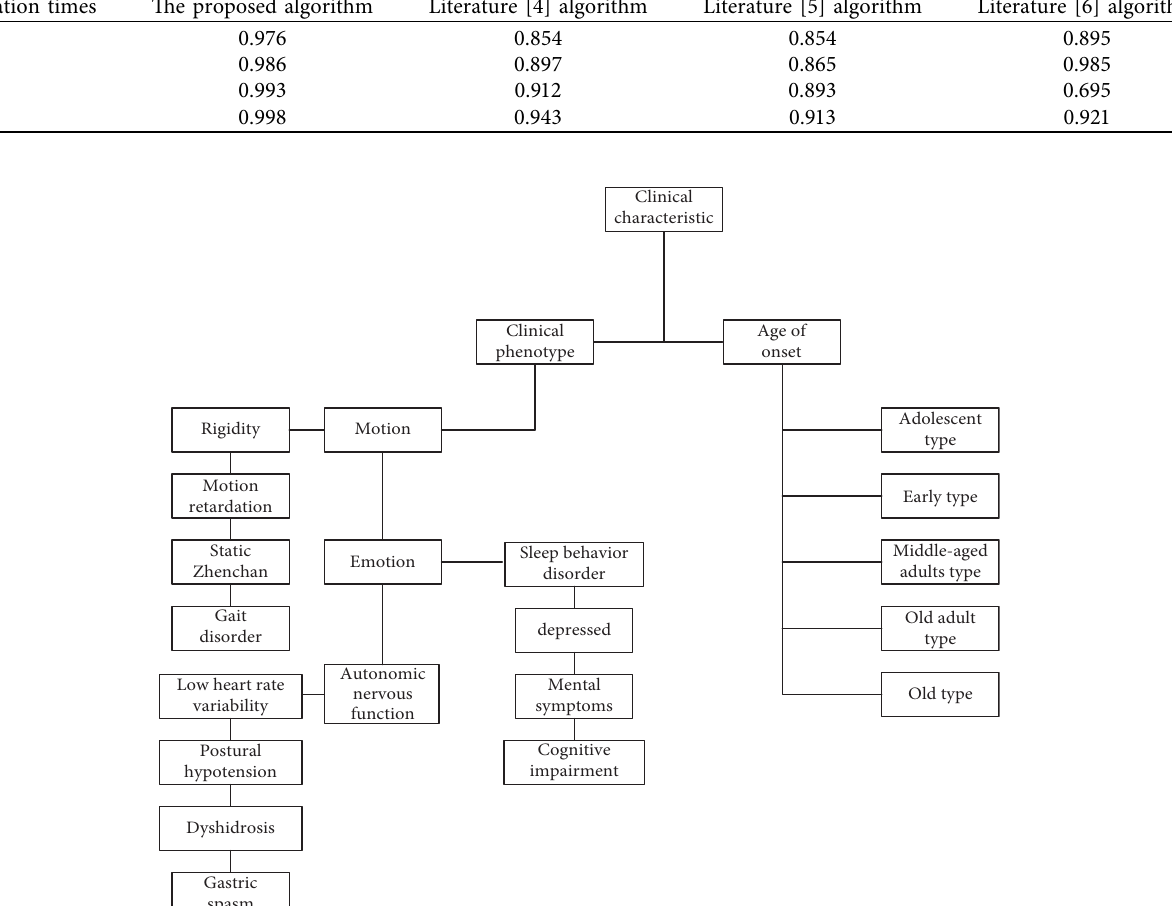
Figure 4: Clinical characteristics of Parkinson’s disease.